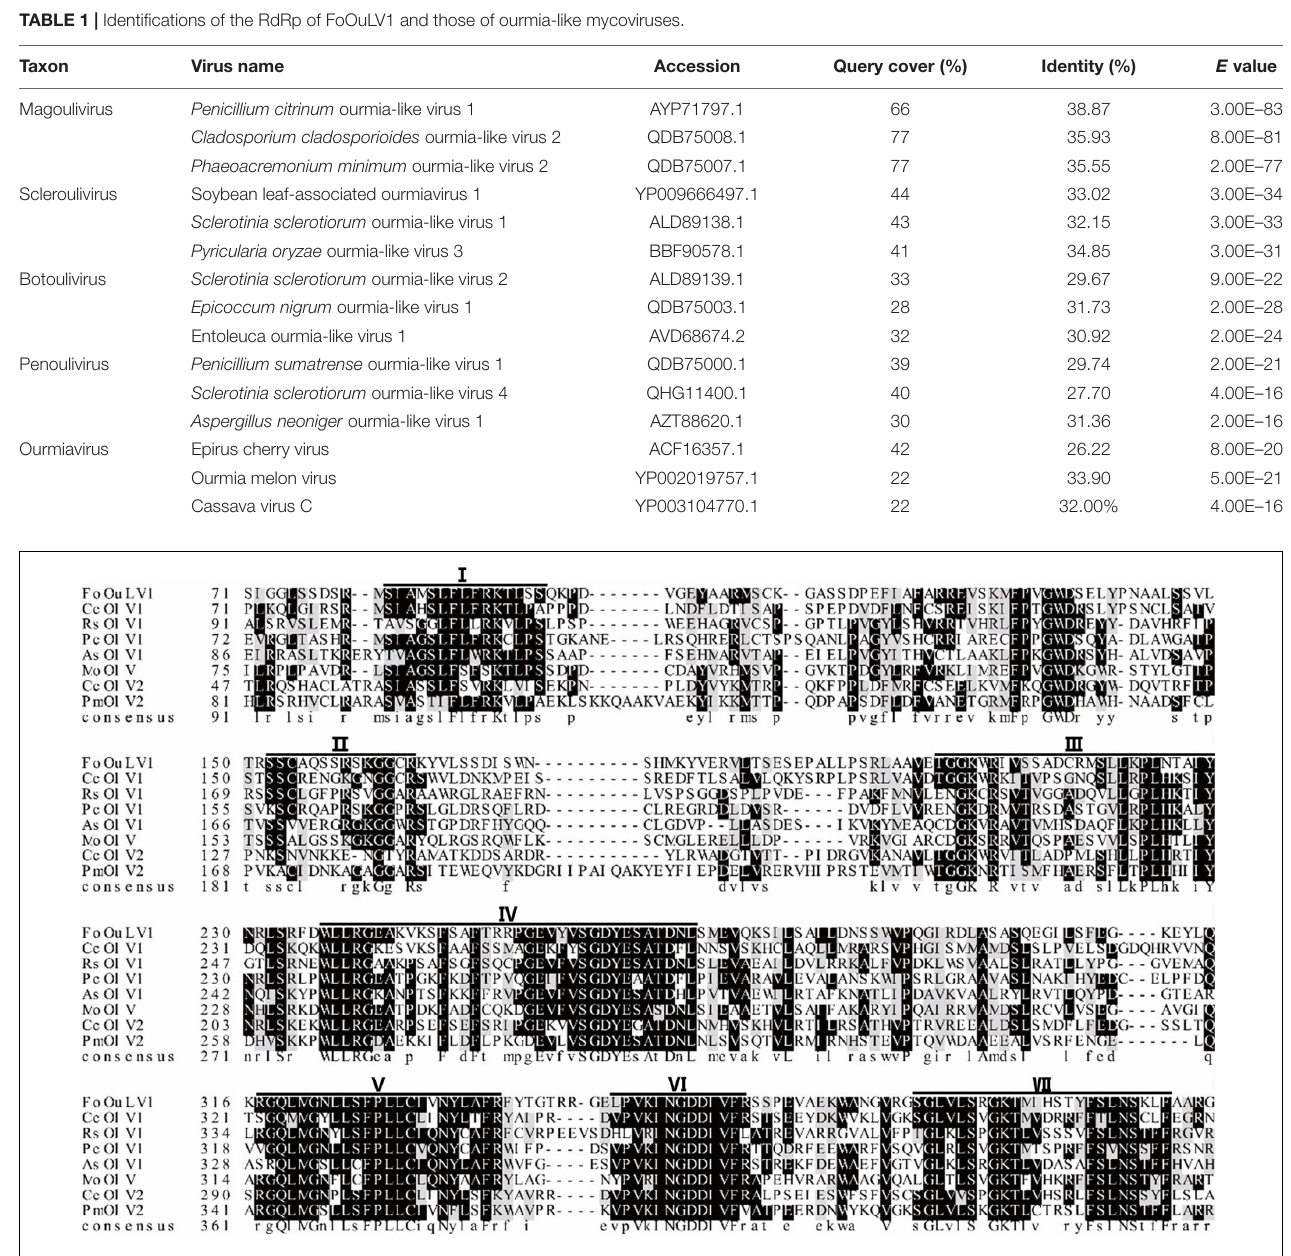
FIGURE 3 | Multiple alignment of the amino acid sequences of RNA-dependent RNA polymerase (RdRp) proteins encoded by FoOuLV1 and other selected ourmia-like viruses. Horizontal lines above the alignment indicate seven motifs (Roman numerals I to VII). Abbreviations: CcOLV1, Cladosporium cladosporioides ourmia-like virus 1; RsOLV1, Rhizoctonia solani ourmia-like virus 1; PcOLV1, Penicillium citrinum ourmia-like virus 1; AsOLV1, Acremonium sclerotigenum ourmia-like virus 1; MoOLV, Magnaporthe oryzae ourmia-like virus; CcOLV2, Cladosporium cladosporioides ourmia-like virus 1; and PmOLV2, Phaeoacremonium minimum ourmia-like virus